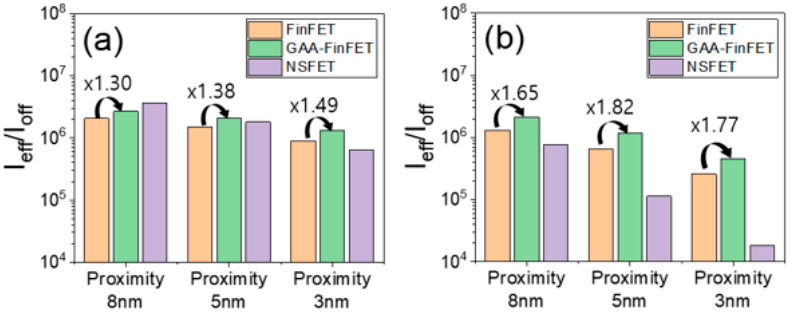
Figure 10. I eff /I off for FinFET, GAA-FinFET, and NSFET. Three proximity values (i.e., 8 nm, 5 nm, and 3 nm) were used at two different doping concentrations in the sub-channel region: ( a ) 1 × 10 18 cm − 3 and ( b ) 5 × 10 17 cm − 3 .